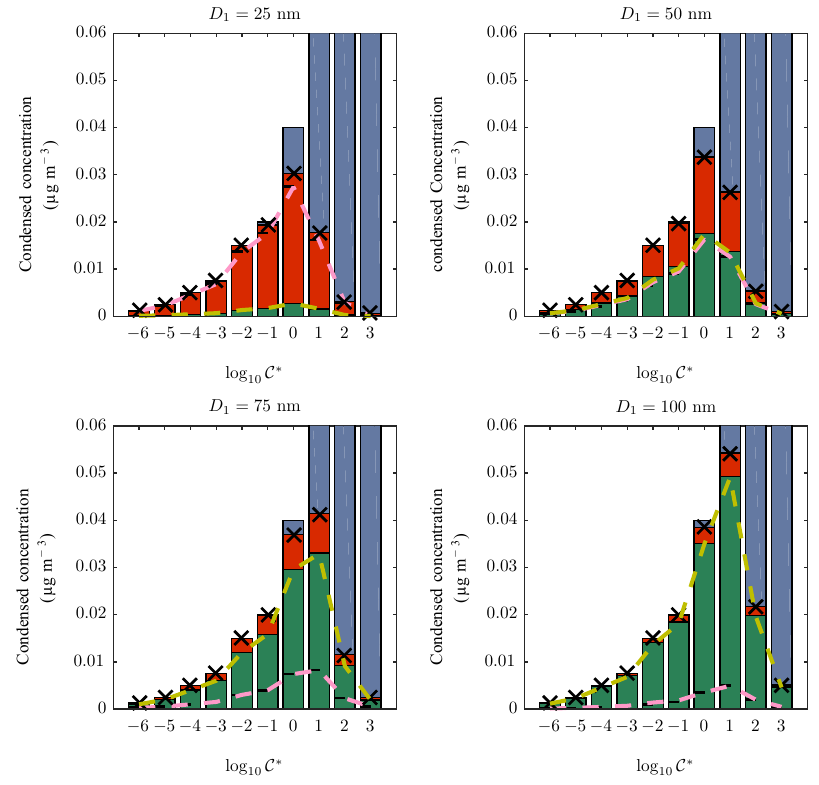
Figure 9. Stacked bar charts showing the condensed concentrations from the two models. Each bar shows the total concentration of organics in each volatility bin and is coloured to show the proportion which is in the vapour phase (blue) and the condensed phases on the first and second modes (green and red, respectively). The height of the horizontal black dashed lines across each bar marks the condensed concentrations on the second mode only (the height of the red regions as measured from the x axis). Total concentrations in each volatility bin from the partitioning theory are shown by the black crosses and the amounts on the first and second modes are shown by the yellow and pink dashed lines, respectively. The y axis is cut off at 0.04 and 0.05 for clarity. The diameter of the first mode is denoted above each plot and the number concentration is 1000cm − 3 , while the second mode has a median diameter of 125nm and a number concentration of 50cm − 3 .